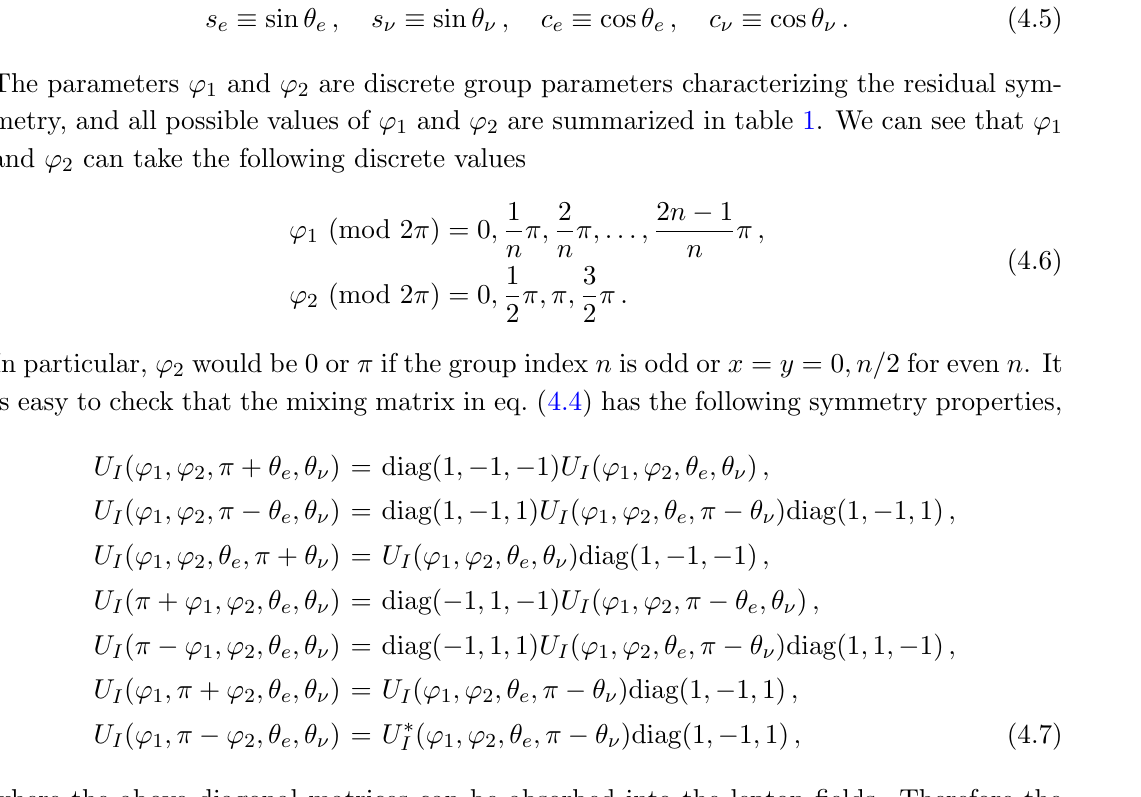
= Z SR z(cid:23) and X (cid:23) = f R (cid:0) z (cid:23) + y ; SR y g , where i and j are the indces of 2 2